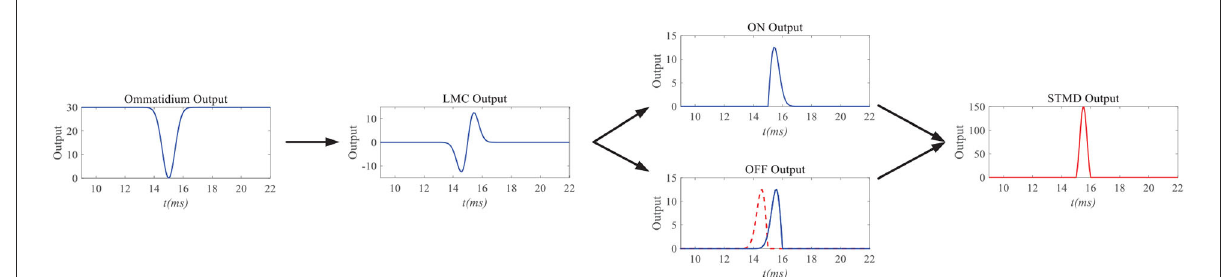
FIGURE3 Neuron responds of the STMD pathway. When a small black target passes through a pixel point ( x , y ), the ommatidium output first drops to zero and then rises to its original position. The ommatidium output transmits to large monopolar cell (LMC) to calulate the changes of brightness over time t . LMC output further conveys to medulla neurons to perform parallel processing. Finally, STMD neuron integrate Tm3 neuron response and Tm1 neuron response to detect small target at pixel point ( x , y ).